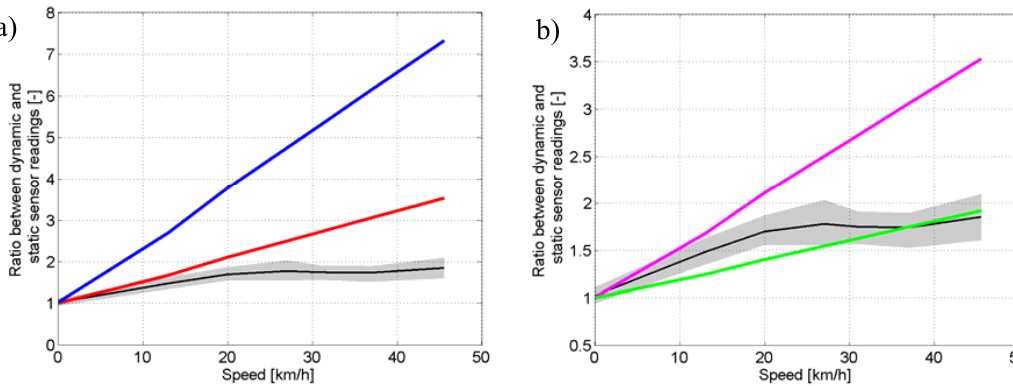
Fig. 8. Black line: experimental results of the car speed simulator with gray uncertainty boundaries. (a) theoretical ratios for assumed rainfall velocity of 2ms − 1 (blue) and 5ms − 1 (red). (b) theoretical ratios for assumed windshield angle of 70 ◦ (green) and 45 ◦ (purple) at an assumed raindrop velocity of 5ms − 1 . The empirical relationship is derived by the car speed simulator and there is no car involved in this experiment.